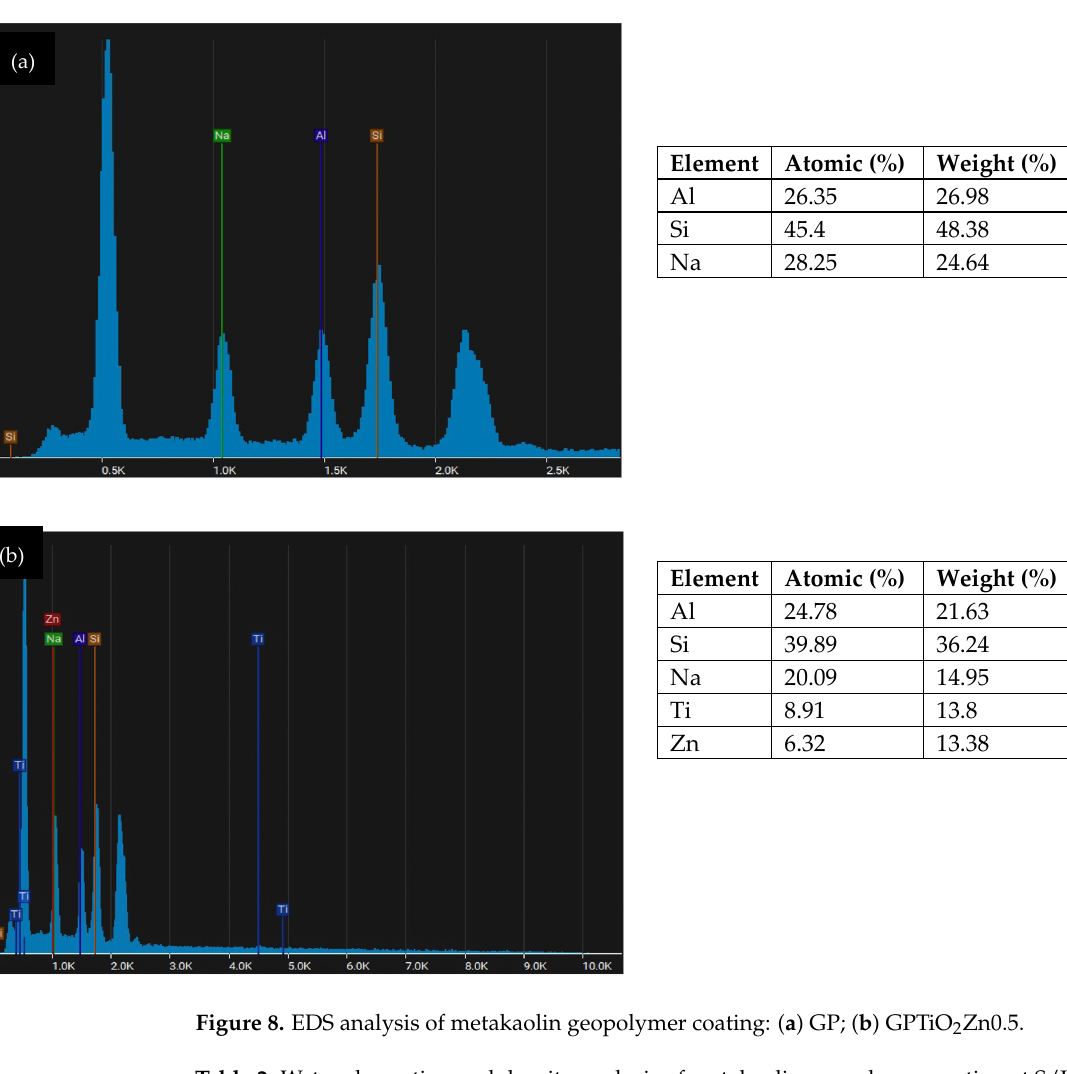
11 of 15 Figure 7. SEM images of metakaolin geopolymer coating: ( a ) GP; ( b ) GPTiO 2 ; ( c ) GPTiO 2 Zn0.1; ( d ) GPTiO 2 Zn0.3; ( e ) GPTiO 2 Zn0.5; ( f ) GPTiO 2 Zn0.7; ( g ) GPTiO 2 Zn0.9. Figure 8a illustrates the EDS spot analysis for metakaolin geopolymer coating (GP)